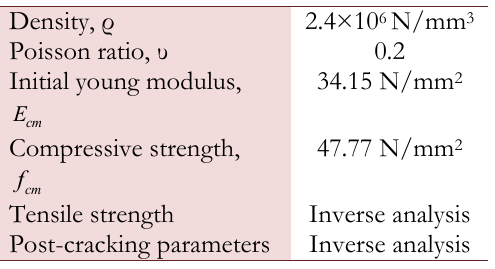
Table 4: Mechanical properties adopted in the numerical